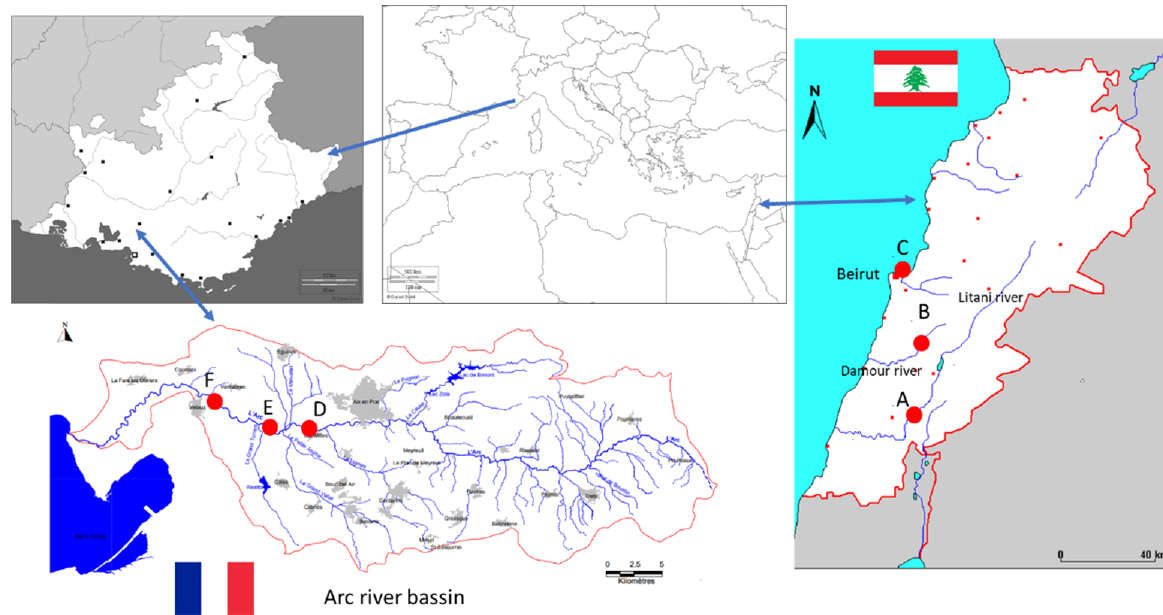
Figure 1. Sampling sites in Lebanon and in France. A, B, C red circles on the right represent the samples sites located in Lebanon: (A) Litani river; (B) Damour river; (C) Al Ghadir. D, E and red circles on the left represent the samples sites located in France: (D) downstream of WWTP1; (E) downstream of WWTP2; (F) Roquefavour.